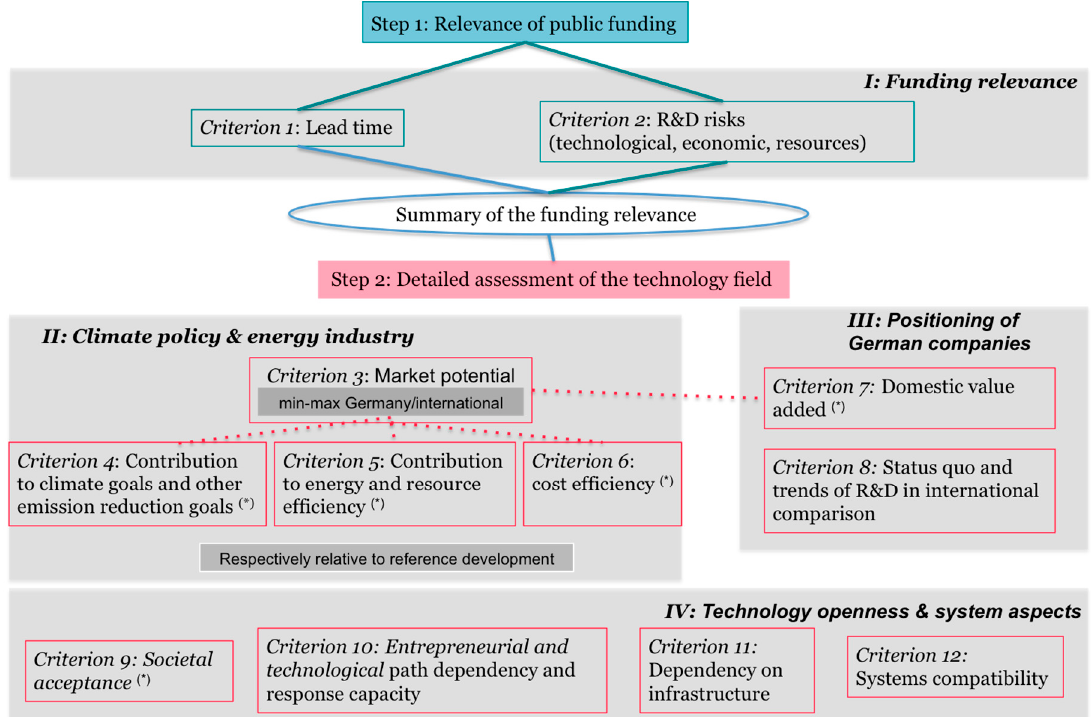
Figure 1. General multi-dimensional analysis framework; criteria that could only partly be applied in the case of Direct Air Capture (DAC) are marked with (*).